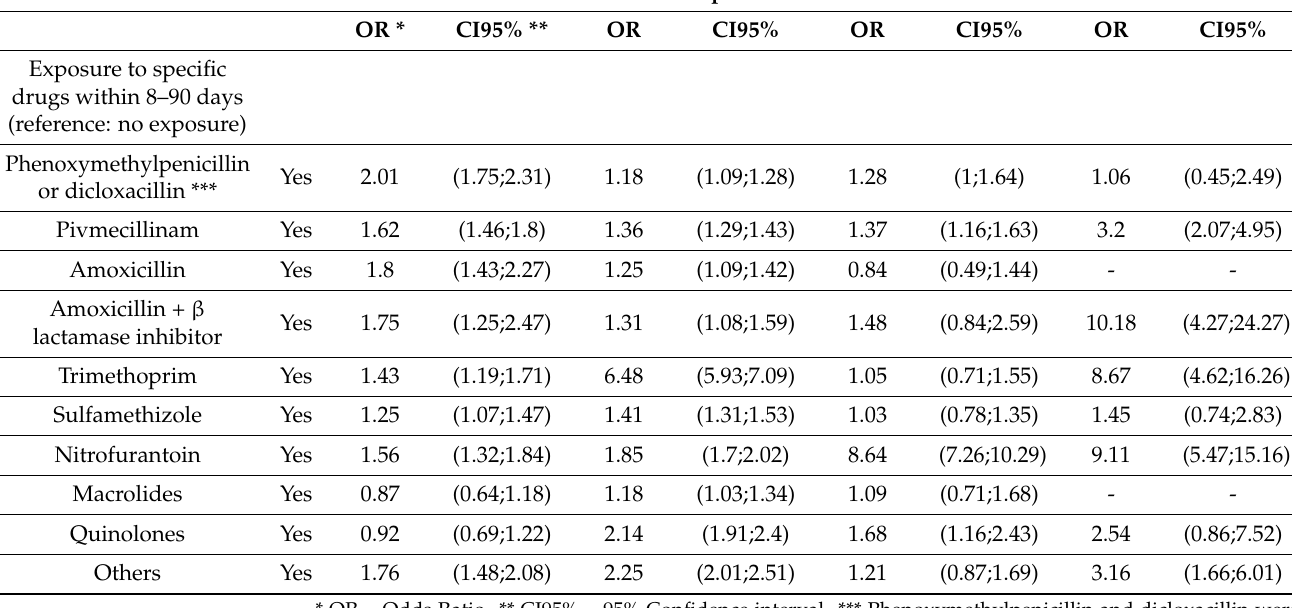
Table 3. Results of adjusted analysis of exposure to specific drugs and odds of resistance. Mecillinam Trimethoprim Nitrofurantoin Multi-Resistance OR * CI95% ** OR CI95% OR